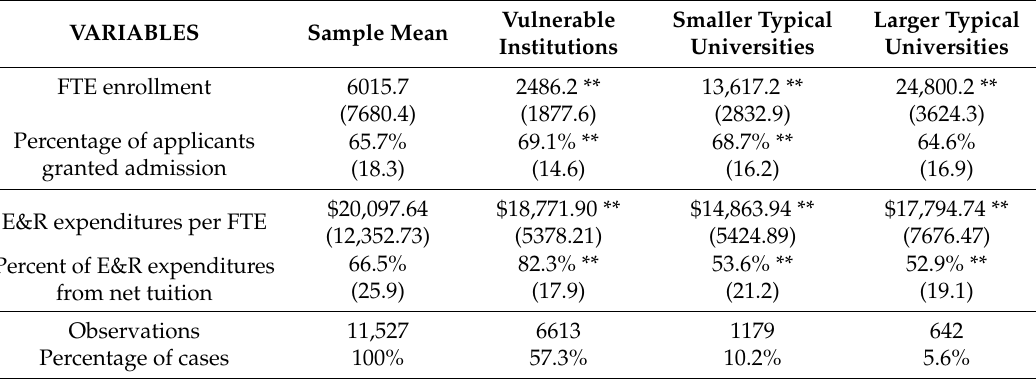
Table 2. Profiles offering less desirable